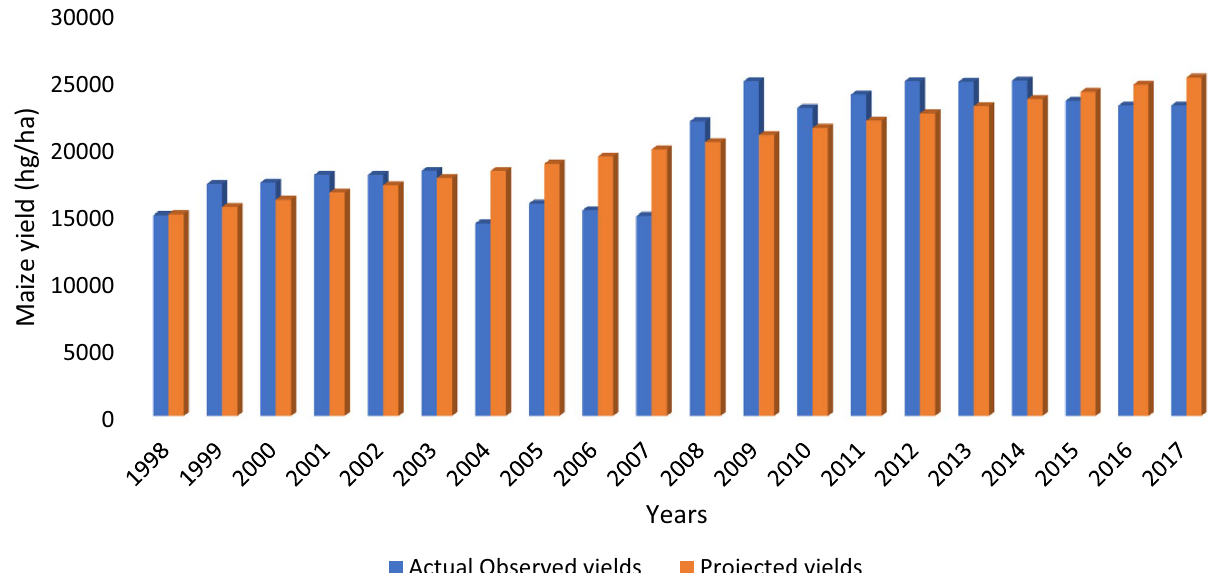
Fig. 5 Actual and projected maize yield in